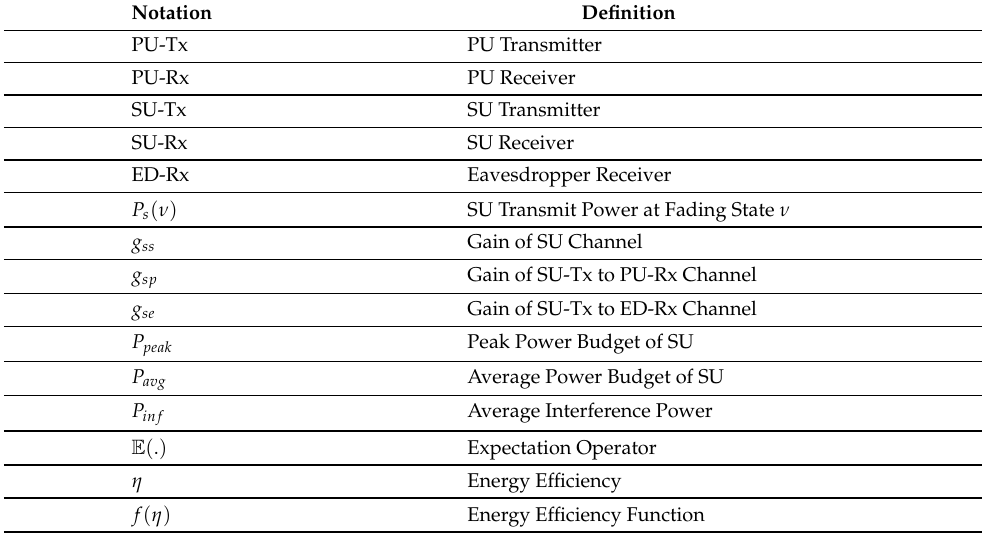
Figure 1. An illustration of the considered CR model. Table 1. Key